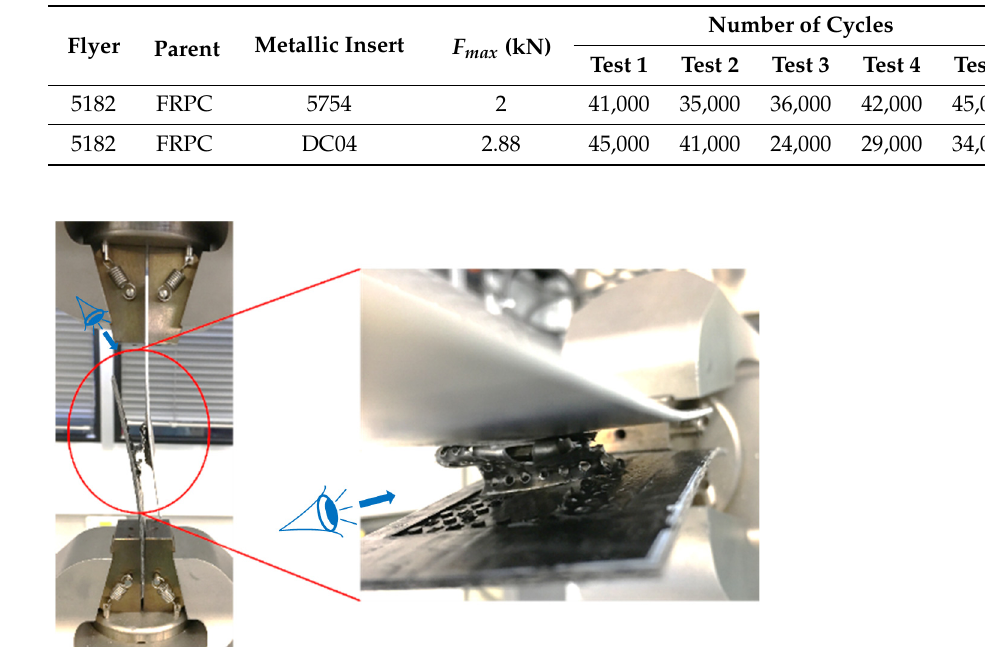
Figure 12. Failure during fatigue test of the joining between the 5182 and aluminum 5754 insert (E = 16